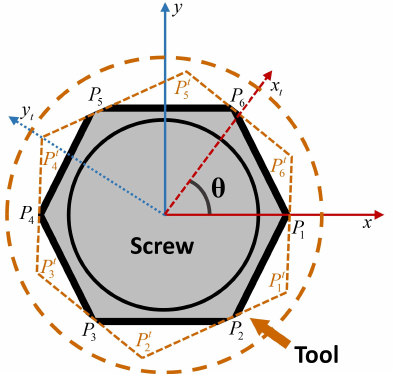
Figure 19. Relative relation between a screw and the